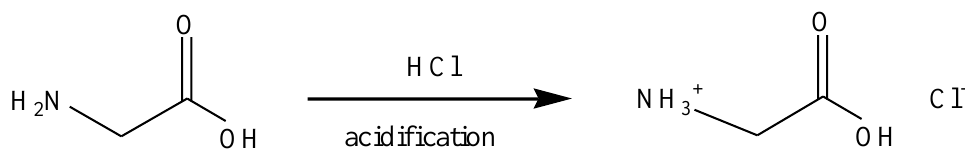
Figure 1. The reaction diagram of chlorinated amino acetic acid